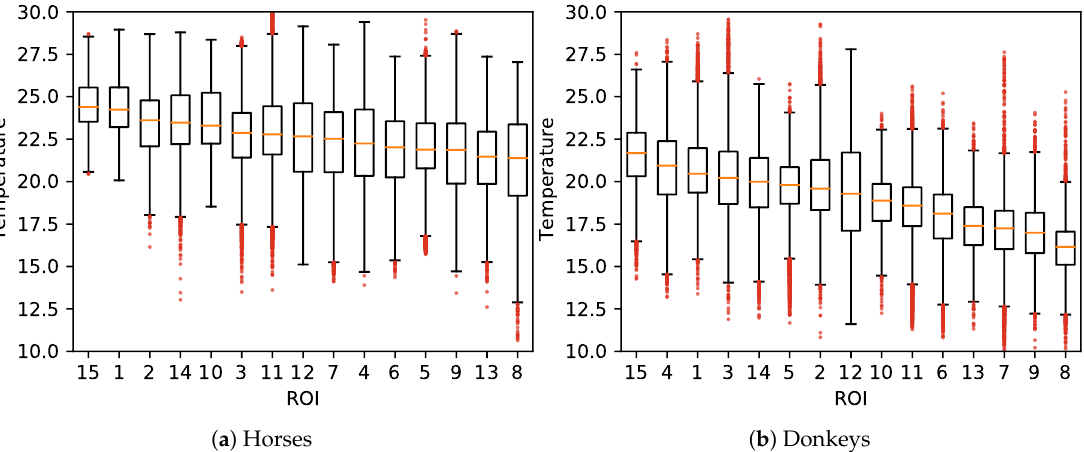
Different superscript letters indicate significant differences between horses and donkeys for hair coat ( a , b ) and SF-Skin ( c , d ) respectively according to the Mann–Whitney–Wilcoxon (MWW) test.